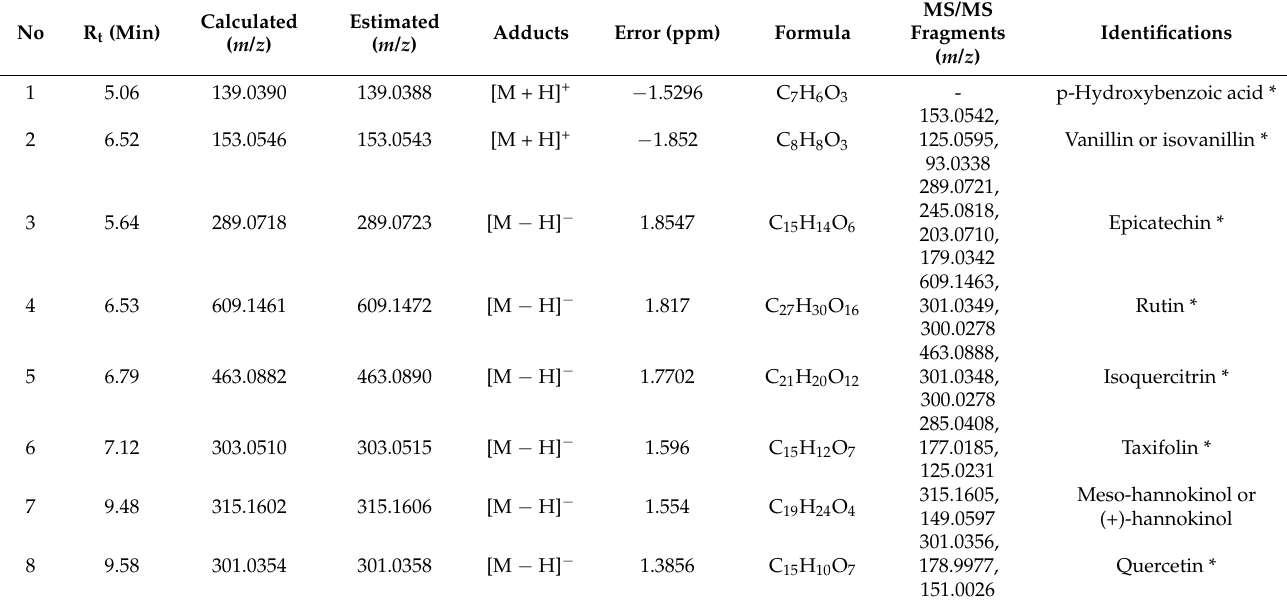
Figure 5. Ultrahigh-performance liquid chromatography–tandem mass spectrometry (UHPLC–MS/MS) chromatograms of ethanol extract of Amomum tsao-ko (EEAT). ( A ) Ultraviolet chromatograms at 210 nm and base peak chromatograms with positive and negative modes of EEAT. ( B ) Individual ion chromatograms of eight components in EEAT. Table 1. List of identified phytochemicals in ethanol extract of Amomum tsao-ko (EEAT) by ultrahigh-performance liquid chromatography-tandem mass spectrometry (UHPLC–MS/MS)